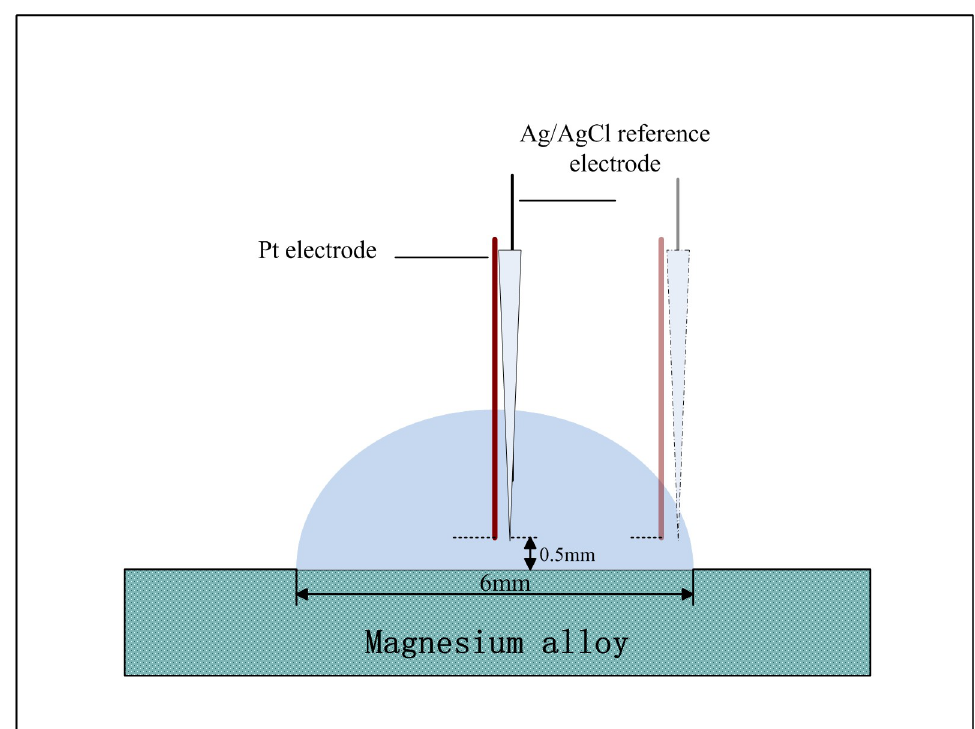
Fig 2. The schematic diagram of the electrochemical